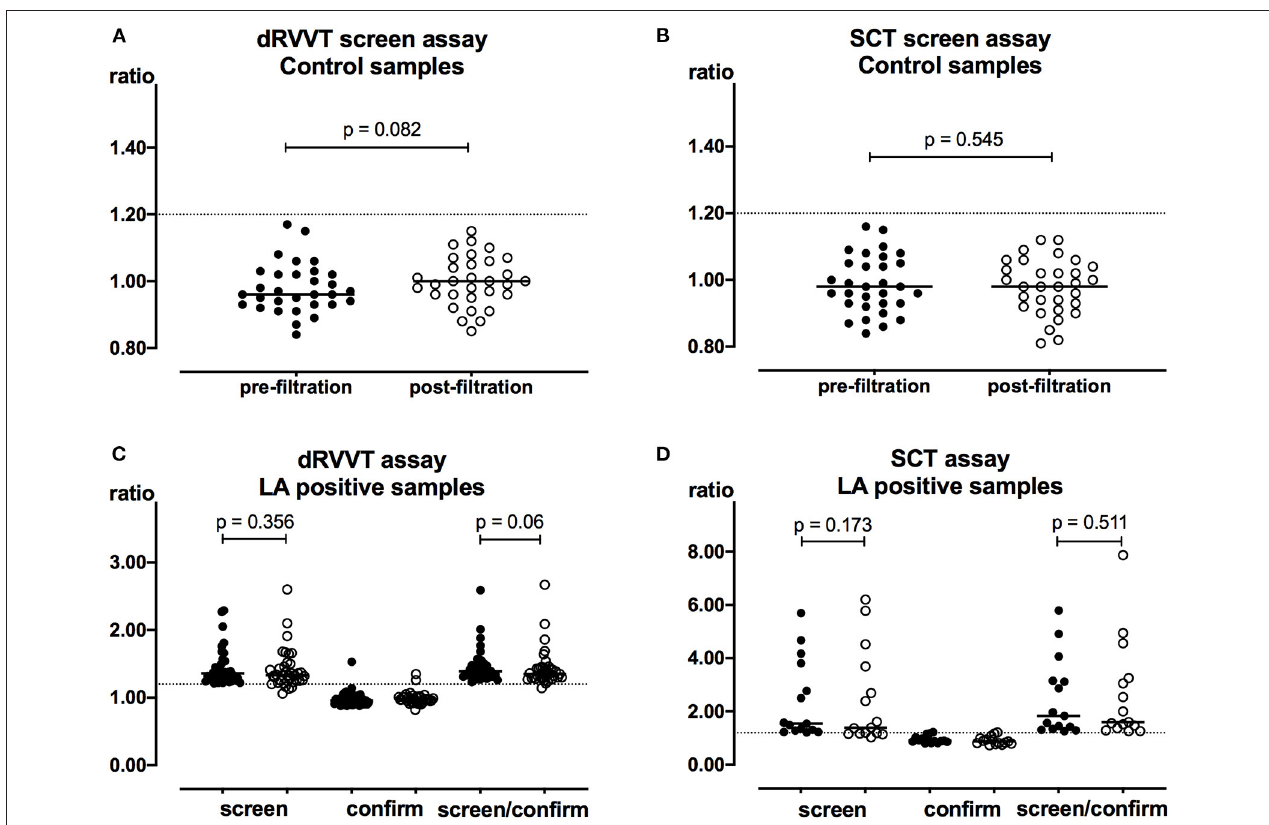
FIGURE 1 | Neutrality of DOAC Filter with regard to LA assays in the absence of FXa inhibitors. Pre- (closed symbols) and post-filtration (open symbols) samples were tested using dRVVT (A) and SCT (B) screen assays in control samples ( n = 31) and using dRVVT (C) and SCT (D) screen and confirm assays in LA-positive samples ( n = 37 and 15, respectively). Dashed line corresponds to the cutoff value of 1.20. Horizontal lines represent median values.